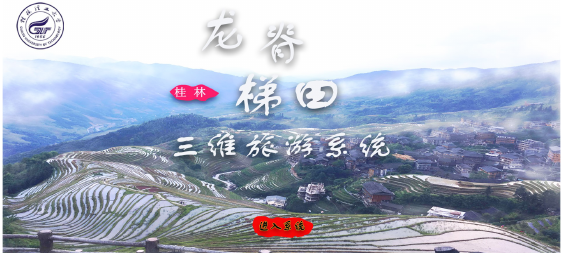
Figure 4. Main interface of 3D tourism system